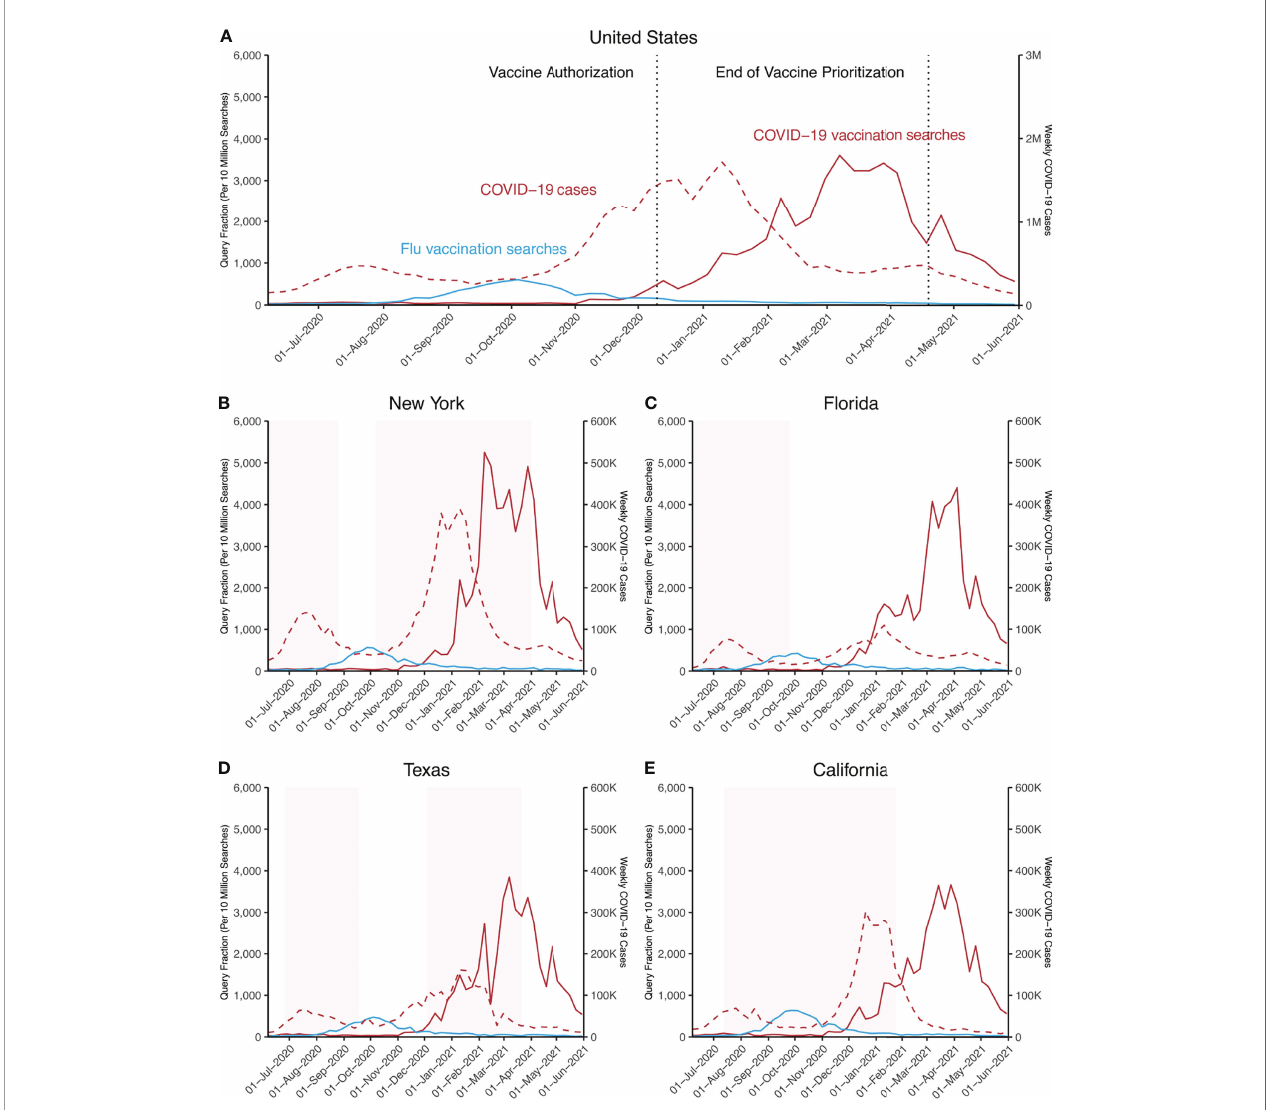
FIGURE 1 | Search Trends for top 10 terms related to COVID-19/in fl uenza vaccination in the US and selected states. Online searches from June 1, 2020, to May 31, 2021, as weekly query fraction per 10 million searches for top 10 terms related to “ vaccine covid 19 ” (indicative of COVID-19 vaccinations) and top 10 terms related to “ fl u shot ” (indicative of in fl uenza vaccinations) are depicted. Data are shown for (A) the United Sates (US) and (B – E) for indicated US states. Fill color gradients (light red) represent periods of pandemic-related restrictions: (B) March 20, 2020 – August 25, 2020 and October 7, 2020 - April 1, 2021; (C) April 1,